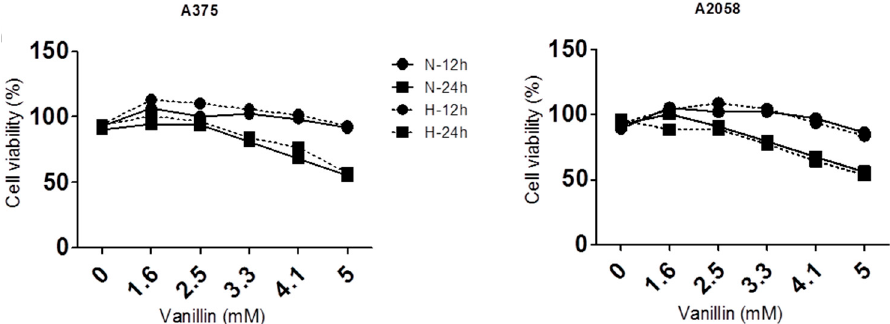
Figure 1. Anti-cancer effects of vanillin upon normoxia or hypoxia. Anti-cancer effects of vanillin in A375 and A2058 malignant melanoma cells. Cells were incubated with 1.6, 2.5, 3.3, 4.1, and 5.0 mM of vanillin for 12 h or 24 h under normoxic (N) or hypoxic (H) condition. Cell viability was measured by crystal violet assay as described in the materials and methods section.